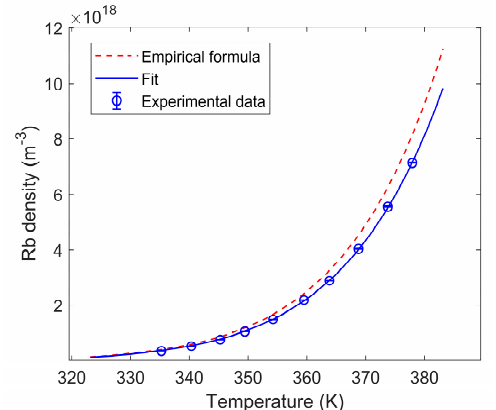
Figure 10. Fitting profile of the experimental results (368.8 K). The 87 Rb transitions between Figure 10. Comparison of experimental results of Spectral absorption and empirical formula hyperfine levels of the ground and excited states of the D1 transitions are plotted as dotted lines.